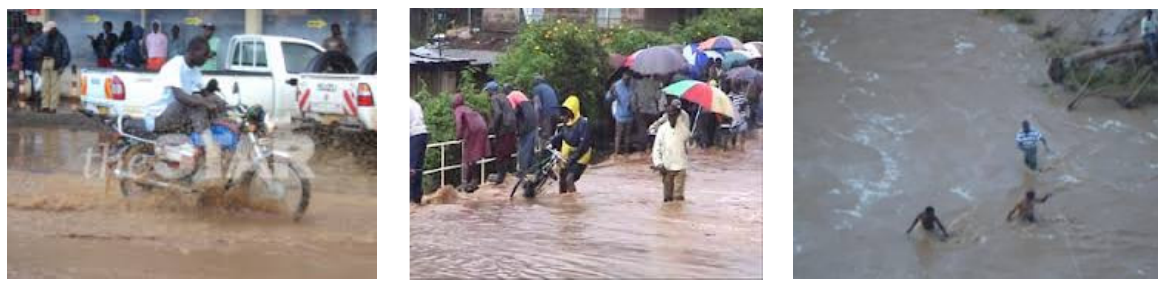
Figure 3. Pluvial-based and river-based flooding scenarios in Eldoret Municipality in